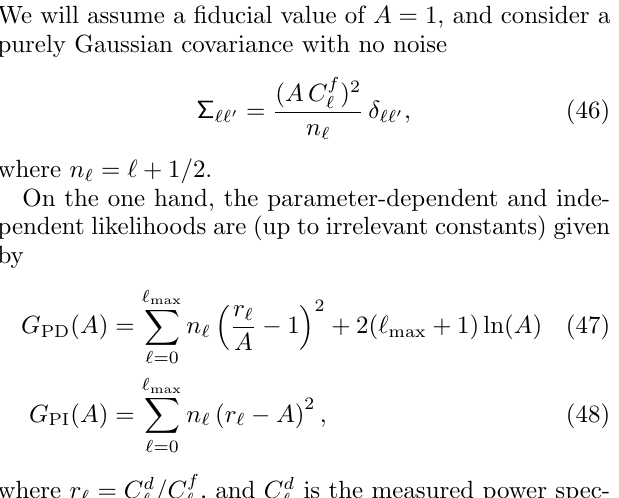
FIG. 1: Left: distribution of maximum-likelihood estimates of an overall power spectrum amplitude parameter in the case of parameter-dependent (red) and parameter-independent (blue) covariances. The parameter dependence of the covariance matrix causes a downwards relative bias with respect to the parameter-independent case, as well as a mild shrinkage of the parameter uncertainties. Results are shown for a small maximum multipole ( (cid:96) max = 10 in order to highlight the effects of the parameter dependence. Right: relative bias (red) and shift in uncertainties (blue) due to the parameter dependence of the covariance matrices as a function of the maximum multipole (cid:96) max (note that both quantities are normalized by the parameter-independent error bars). The red circles show the values found by directly evaluating the exact likelihood for 10 6 simulations, while the solid lines show the values found in our Fisher matrix approximation. The Fisher approach is able to reproduce the exact result with good accuracy for both quantities, slightly over-estimating the bias for small (cid:96) max